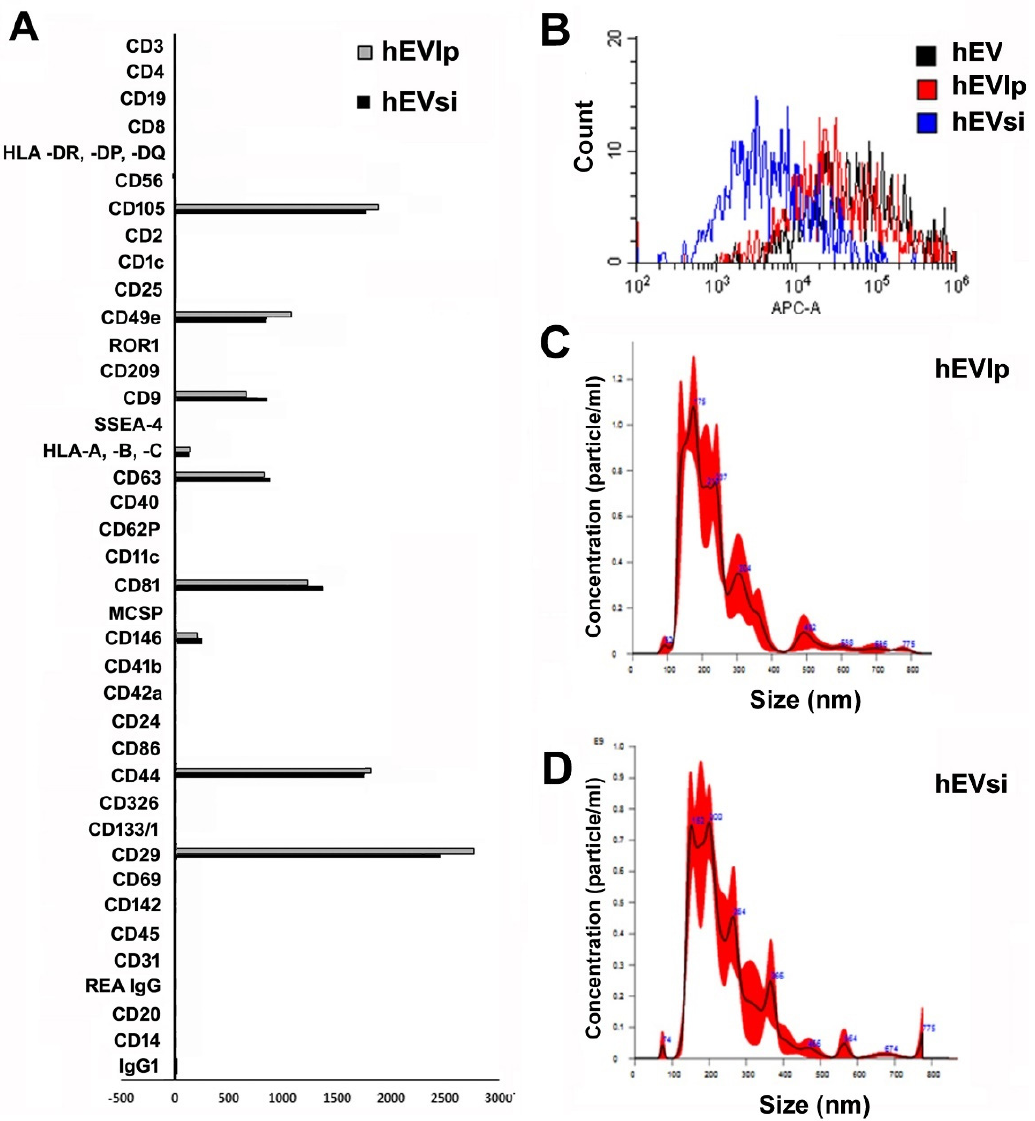
Figure 1. Characterization of extracellular vesicles (EVs). ( A ) The surface molecular profiles of hEVlp and hEVsi were determined using a multiplex bead-based flow cytometry assay with 39 multi- plexed populations of dye-labeled antibody-coated capture beads. The graph shows the quantification of the median allophycocyanin (APC) fluorescence values for all bead populations after background correction (medium control values subtracted from measured EV values) of representative hEVlp and hEVsi samples (n = 3 samples analyzed with similar results). No differences were observed among the EVs obtained from human mesenchymal stromal cells (hMSCs) transfected in the presence (hEVsi) or absence (hEVlp) of a CD73-specific small interfering RNA (siRNA). ( B ) Representative cytofluorimetric analyses of EVs obtained from naïve hMSCs (hEVs) and from hMSCs transfected in the presence (hEVsi) or absence (hEVlp) of the specific siRNA (n = 3 samples analyzed with similar results). The black line represents the fluorescence intensity of hEVs incubated with CD73 antibody; this line is superimposable on the red line showing the fluorescence intensity of EVs obtained from lipofectamine-transfected hMSCs (hEVlp). The blue line represents the fluorescence intensity of EVs obtained from CD73-silenced hMSCs (hEVsi). ( C , D ) Representative graphs of nanoparticle tracking analysis showing the size distribution of ( C ) hEVlp and ( D ) hEVsi. The downregulation of CD73 was also confirmed on EVs derived from rat MSCs (rMSCs) transfected in the presence of the specific siRNA (rEVsi; Figure 2A). The mean